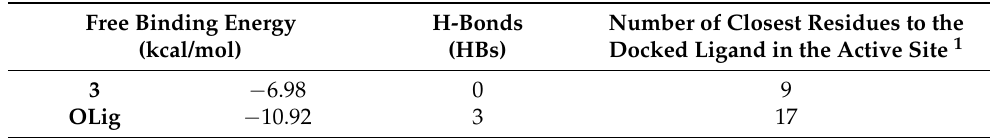
Table 3. Inhibition concentrations, docking binding energies, hydrogen bonds, and the number of closest residues to the docked compounds 3 and OLig